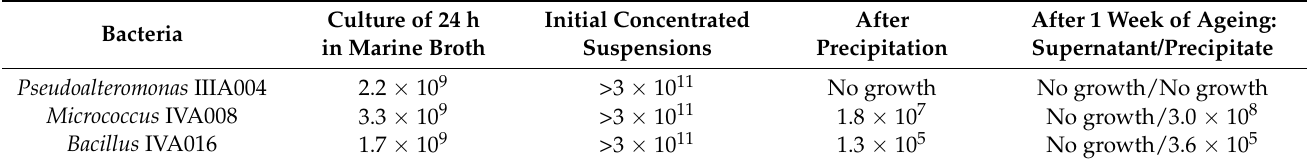
Table 4. Numeration of bacteria (CFU mL − 1